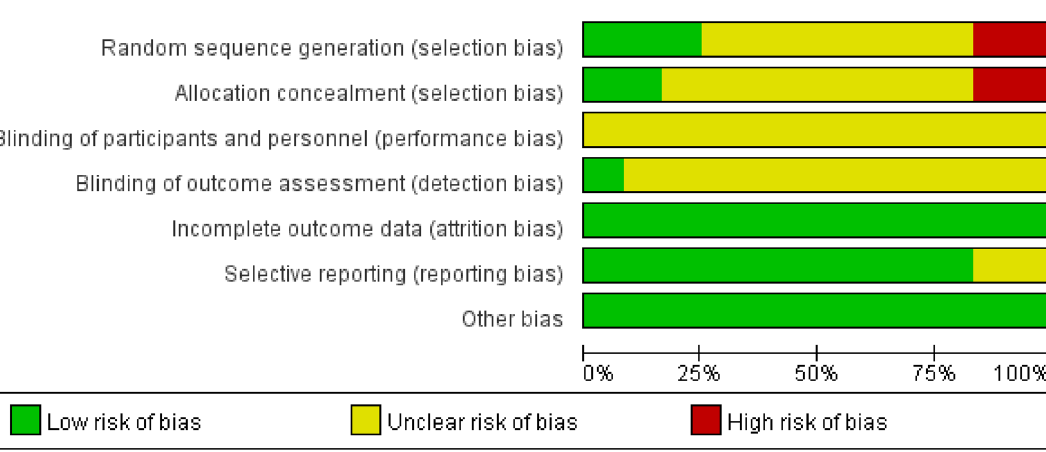
Figure 2. Risk of bias graph: review authors’ judgements about each risk of bias item presented as percentages across all included